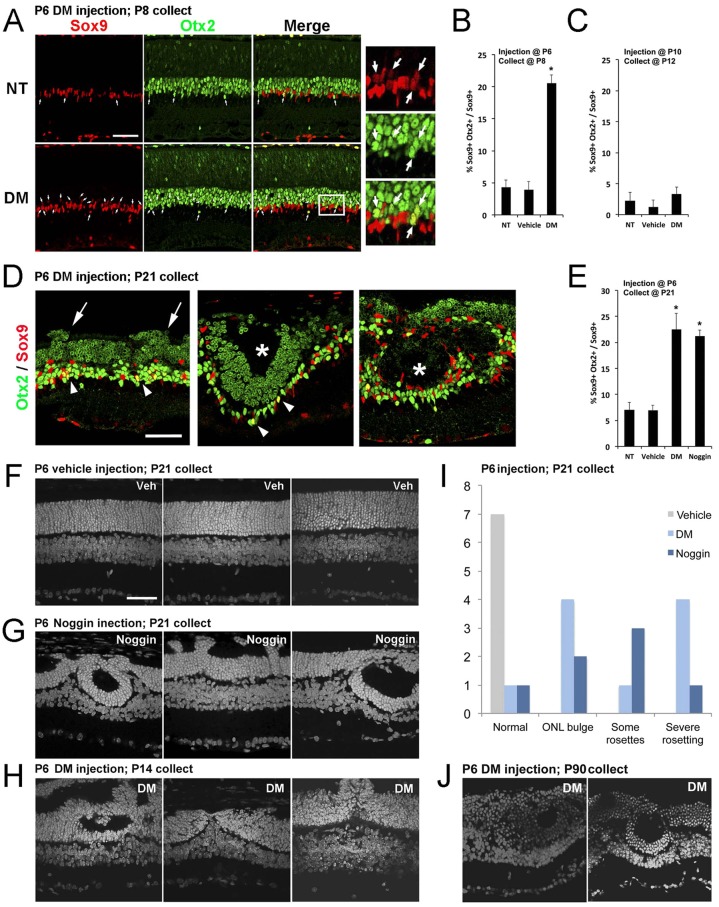
Inhibition of BMP signaling at P6 leads to long-term changes in Müller glia and retinal structure. (A) DM injected at P6, collected at P8 and labeled for Otx2 (green) and Sox9 (red). Arrows: Otx2+/Sox9+ cells. Box shows image at higher magnification. Scale bar: 50 µm. (B) Otx2+/Sox9+ cells/total Sox9+ cells, with DM injected at P6 and retinas collected at P8. (C) Otx2+/Sox9+ cells/total Sox9+ cells, with DM injected at P10 and retinas collected at P12. *P<0.05 with t-test (n=6-17 per group). (D) DM injected at P6, collected at P21. DM-treated retinas contained ‘mushroom-like’ bulges of photoreceptors (arrows) or rosettes (asterisks), and Otx2+/Sox9+ cells (arrowheads). (E) Otx2+/Sox9+ cells/total Sox9+ cells, with DM or Nog injected at P6 and retinas collected at P21. (F) Vehicle injection at P6 does not cause this phenotype. (G,H,J) Examples of retinas injected at P6 with DM or Nog and collected at P14 (H), P21 (G) or P90 (J). (I) Graph of morphological changes from P6 DM or Nog injections, P21 collection.